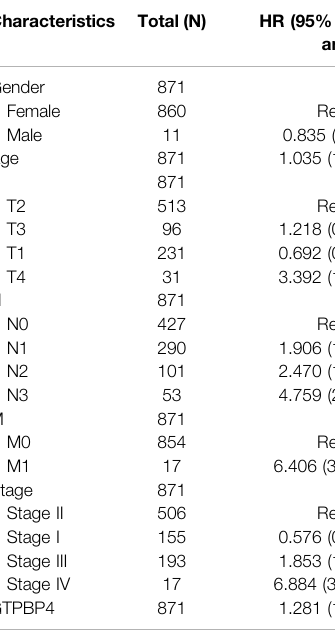
TABLE 2 | Clinical information for these